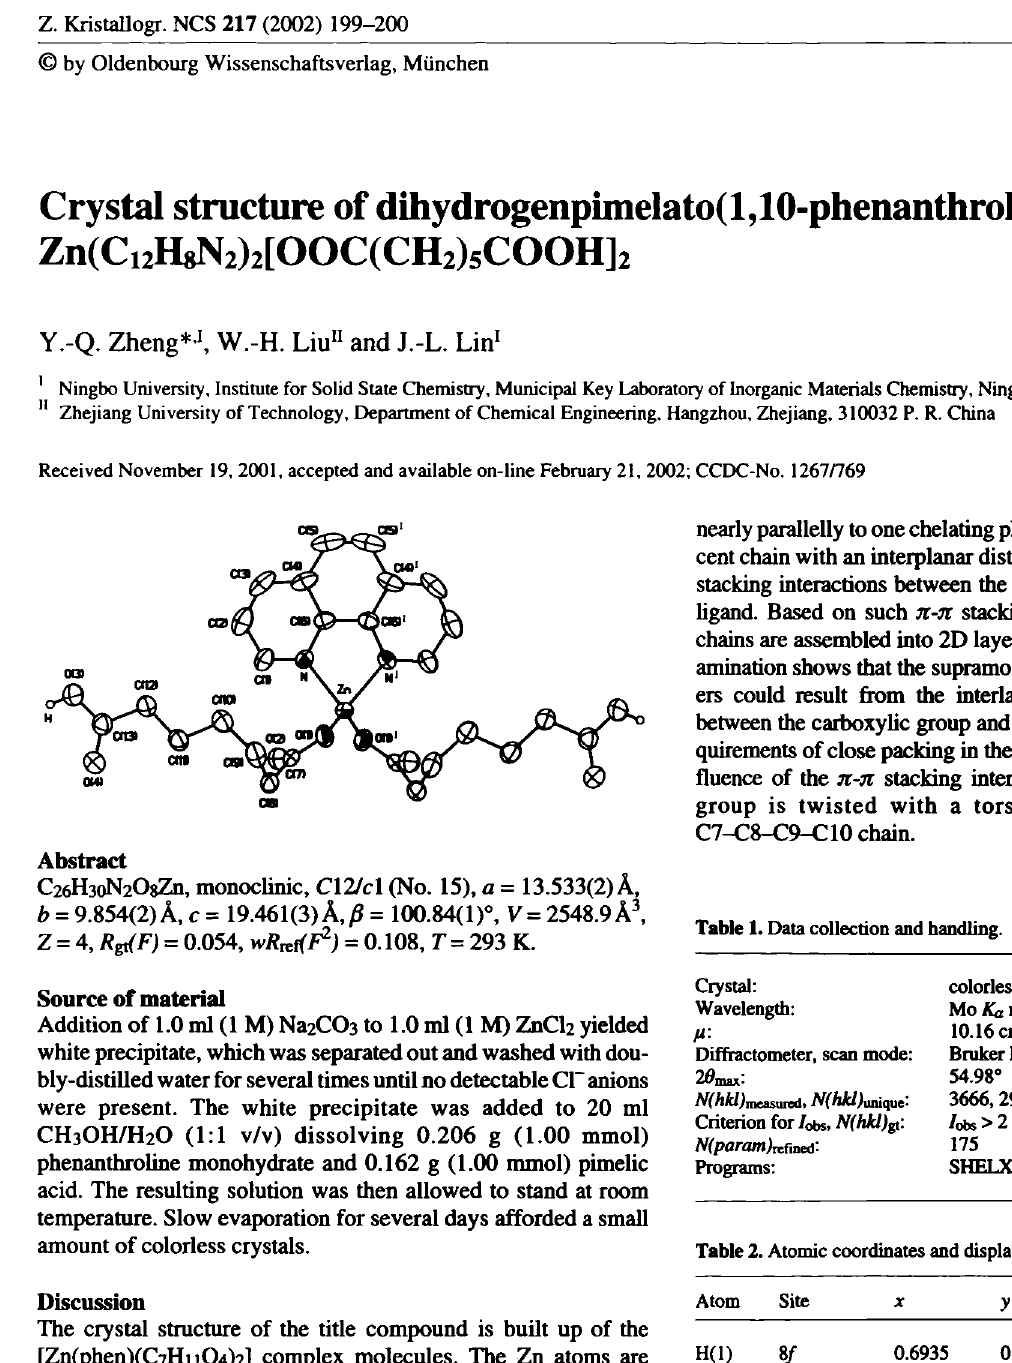
Table 2. Atomic coordinates and displacement parameters (in Â 2